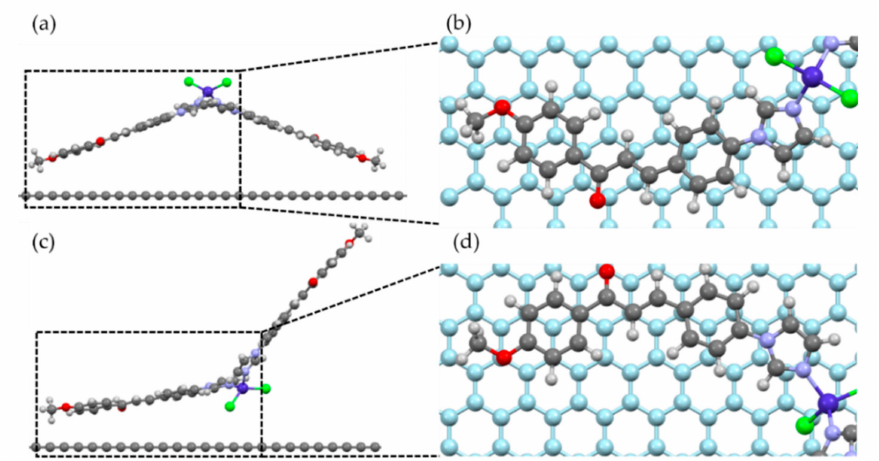
Figure 7. Initial position of the two geometries used for the simulation of molecular adsorption on graphene. As referred to in the text, ( a ) Geometry 1, ( b ) top view of the selected part of ( a ), with the graphene substrate in light blue; the closest carbon atom of the molecule to the substrate was placed in the center of one of the graphene rings. ( c ) Geometry 2, and ( d ) top view of the selected part of ( c